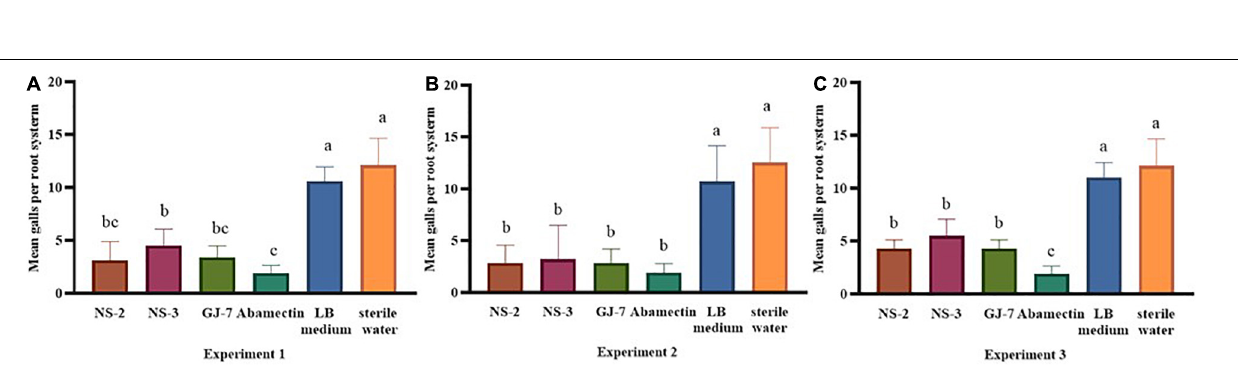
FIGURE 3 | The rhizosphere bacterial strains NS-2, NS-3, and GJ-7 in biological control potential of Panax notoginseng plants infected with Meloidogyne hapla in three treatments of pot experiment. Means in each column followed by the same letter do not differ significantly according to Duncan’s multiple range test at P ≤